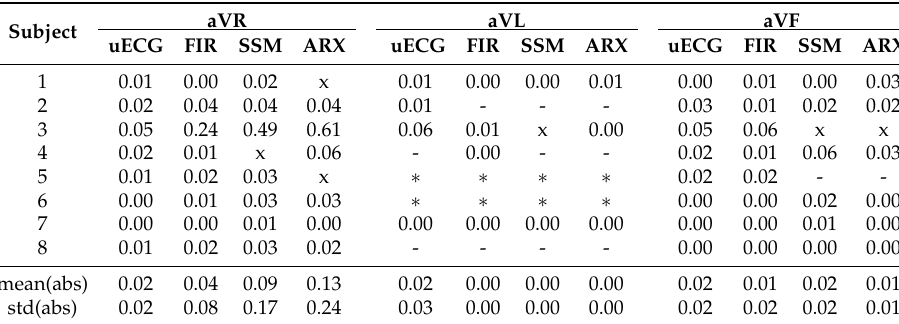
Table A1. Mean squared error for the amplitude deviation of the P waves.